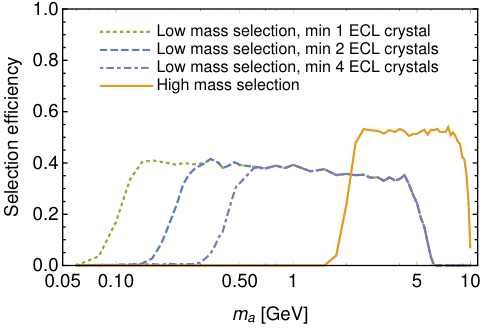
Figure 6 . Belle II 3 (cid:13) e(cid:14)ciency as function of ALP mass after the (cid:12)nal selection. The di(cid:11)erent low mass selections correspond to a minimum photon separation of 1, 2, and 4 crystals in the ECL which is an approximation for the expected performance of an improved reconstruction, the default reconstruction and the reconstruction in the (cid:12)rst trigger level (see text for